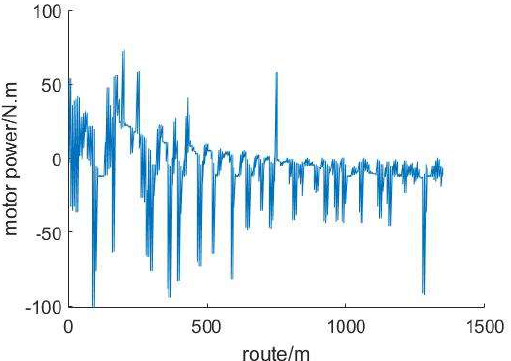
Figure 19. Logic gate control motor power.